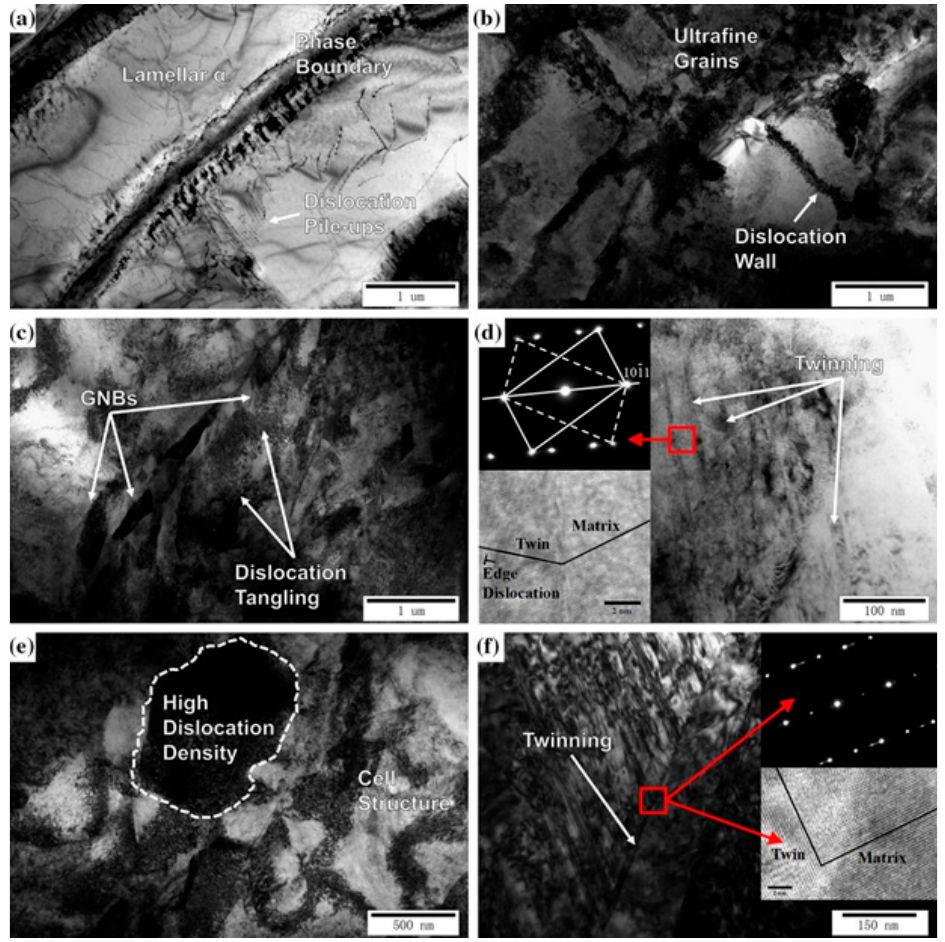
Figure 27. TEM images after different passes [146]: ( a ) as-received; ( b ) one pass; ( c , d ) two passes; ( e , f ) three passes. Reproduced with permission from Springer Nature.